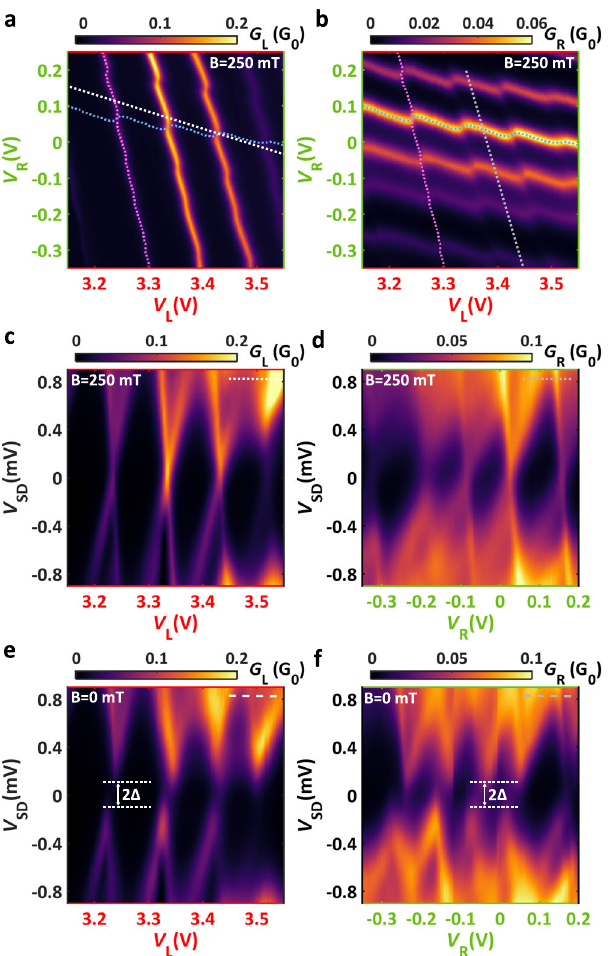
Fig. 2 QD characterization. a , b Zero-bias stability maps of the left and right QDs in the normal state. Finite capacitance between the plunger gates to the opposite QDs with the strong inter-dot Coulomb repulsion establishes a honeycomb structure in the phase diagram. c , d Bias spectroscopy of the left and right QDs in the normal state and e , f in the superconducting state along the white and gray dotted lines in panels ( a , b ). U LR = 0.15 meV was read off from the phase diagram, while charging energies of the left and right QDs were extracted as U L = 0.9 meV and U R = 0.7 meV, respectively, with Δ = 0.15 meV from the Coulomb-blockade spec- troscopy. The couplings were estimated to be Γ L ≈ 0.28 meV and ≈ 0.45 meV. Γ R